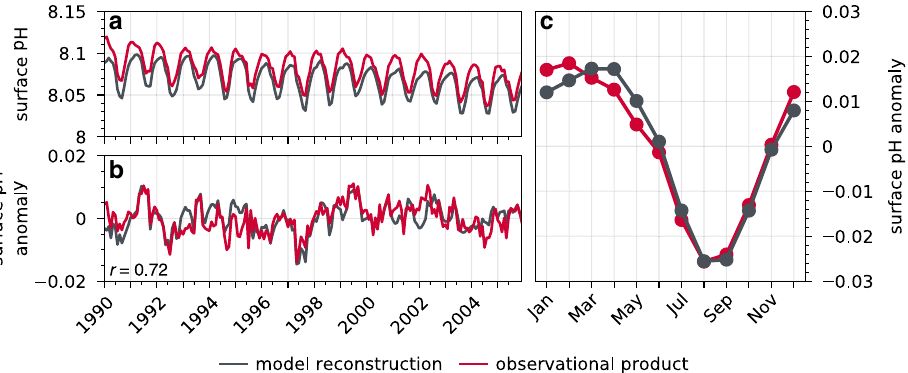
Fig. 2 Area-weighted temporal evaluation of surface pH. a Monthly surface pH in the California Current over 1990 – 2005 for the model reconstruction (black) and observational product (red). b As in a , but for anomalies after removing a second-order polynomial fi t and the seasonal cycle. The correlation coef fi cient between the observational product and model reconstruction is shown in the bottom left of b . c As in the other panels, but for the mean